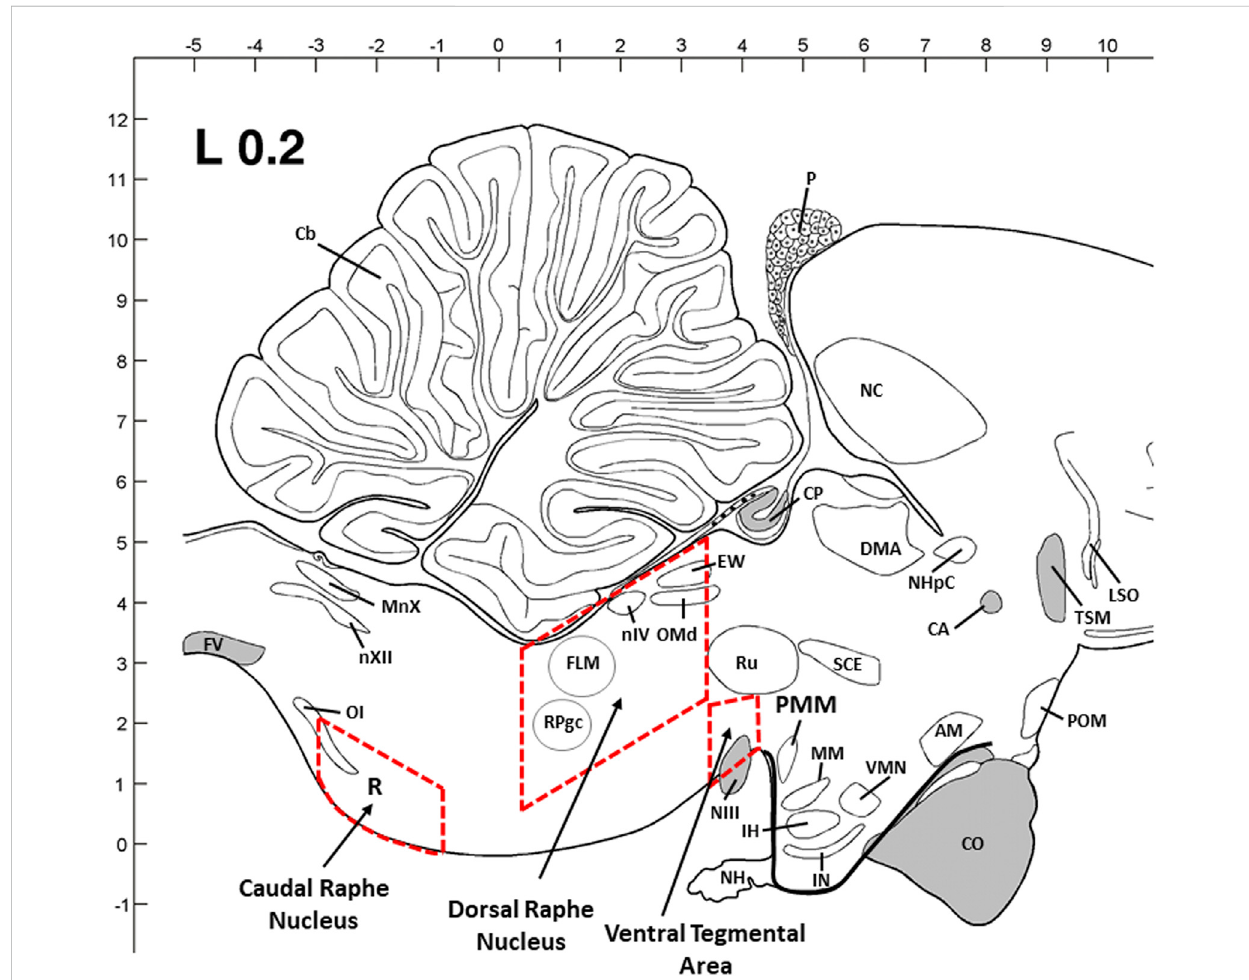
FIGURE 5 Sagittalview ofthreedissection areasofthechickenbrain[dorsal raphenucleus(DRN) andcaudalraphenucleus (CRN)ofthebrainstem andventral tegmental rea (VTA) of the midbrain]. Dimensions of the dissected tissues are coronal with 2.5 – 3 mm (W) x 1 – 1.5 mm (H) x 2.5 – 3.0 mm (L) for DRN, 2 – 2.5 mm (W) x 1 – 1.2 mm (H) x 2.5 – 3.0 mm (L) for CRN, and 3 – 3.5 mm (W) x 2 – 3 mm (H) x 1 – 1.2 mm (L) for VTA. The thickness (W, H, and L) was adjusted proportionally from young birds to older birds based on the brain size and structure. Abbreviations: AM: anterior medial hypothalamic nucleus; CA: anterior commissure; Cb: cerebellum; CO: optic chiasma; CP: posterior commissure; DMA: dorsomedial nucleus; EW: Edinger – Westphal nucleus;FLM:mediallongitudinalfasciculus;FV:ventralfasciculus;IH:inferiorhypothalamicnucleus;IN:infundibularhypothalamicnucleus;LSO:lateral